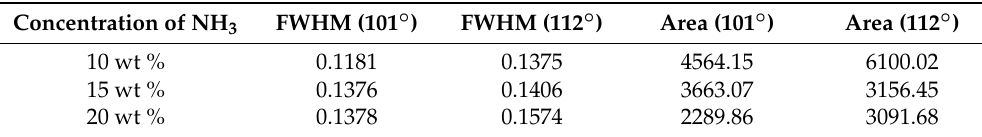
Figure 3. XRD patterns of NH 4 ReO 4 crystals at different NH 3 wt %: ( a ) 10%, ( b ) 15%, ( c ) 20%. Table 2. XRD information of NH 4 ReO 4 crystals at different NH 3 wt %. FWHM, full width at half maximum.